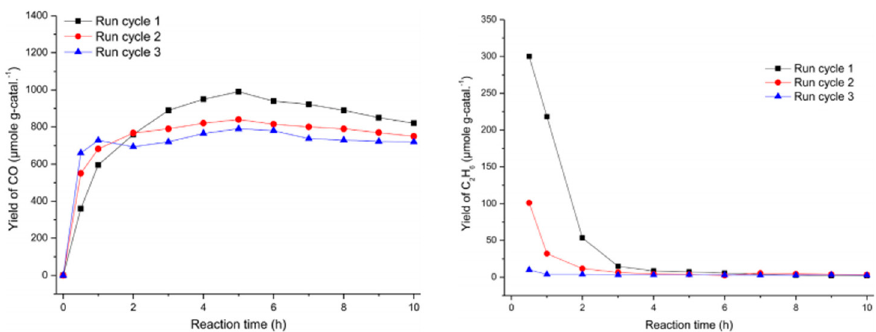
Figure 28. Yield of carbon monoxide and ethane under montmorillonite (MMT)-modified TiO 2 performing photocatalytic methane reforming. Copyright (2015), reprinted from [32] with permission from Elsevier.